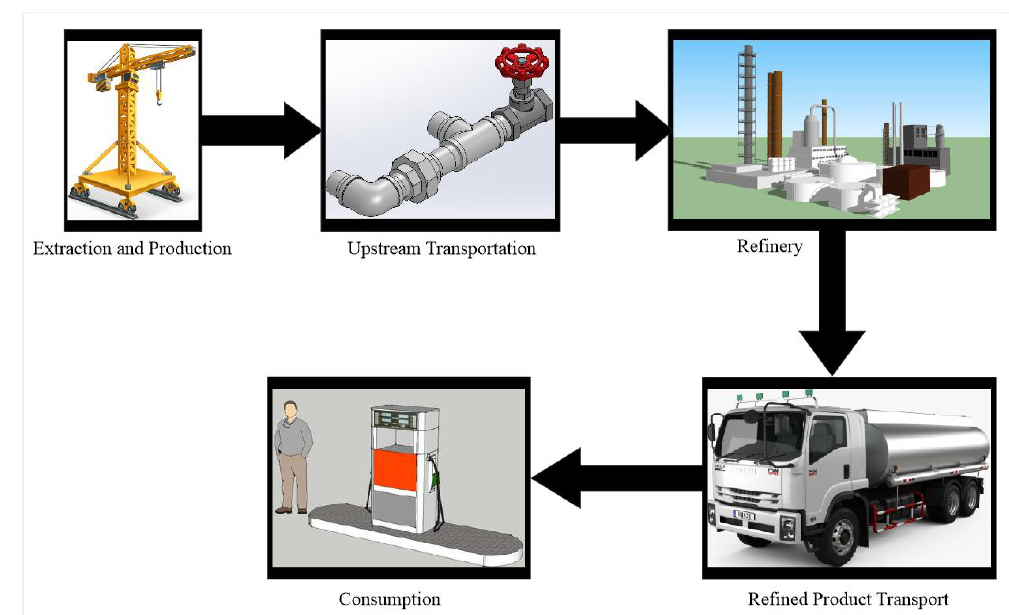
Figure 1. Cycle of petroleum products. Table 1. Means of transportation of oil and gas. Transport Description Rank Pipelines Most common, cheapest of all and safest. 1 Ships Very common and second cheapest 2 Rails Used due insufficient pipeline capacity. Trucks Road transport is inefficient and the most expensive.